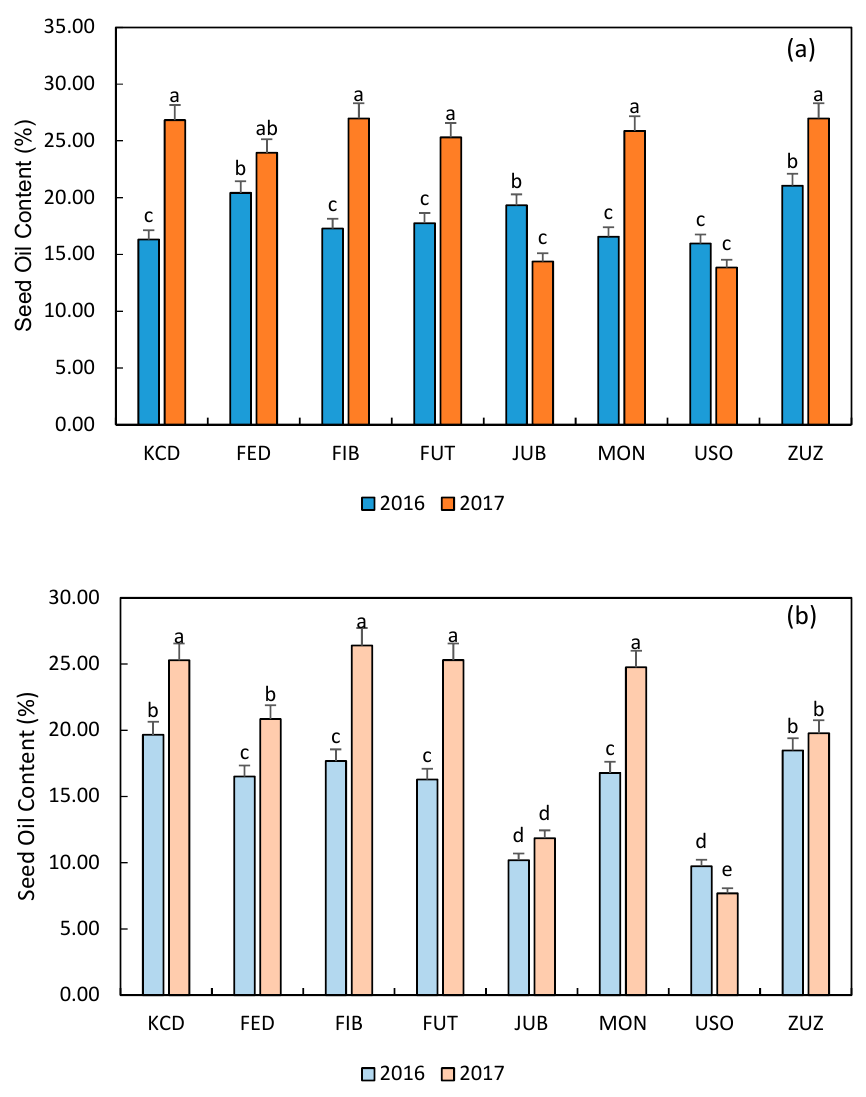
Figure 5. Seed oil content in control plants ( a ) and in plants with inflorescence harvested at flowering ( b ) (KCD = KC Dora; FED = Fedora 17; FIB = Fibrol; FUT = Futura 75; JUB = Jubileu; MON = Monoica; USO = Uso-31; ZUZ = Zuzana). Means followed by the same letter are not significantly different (SNK at the 5% level). Error bars are standard deviations.